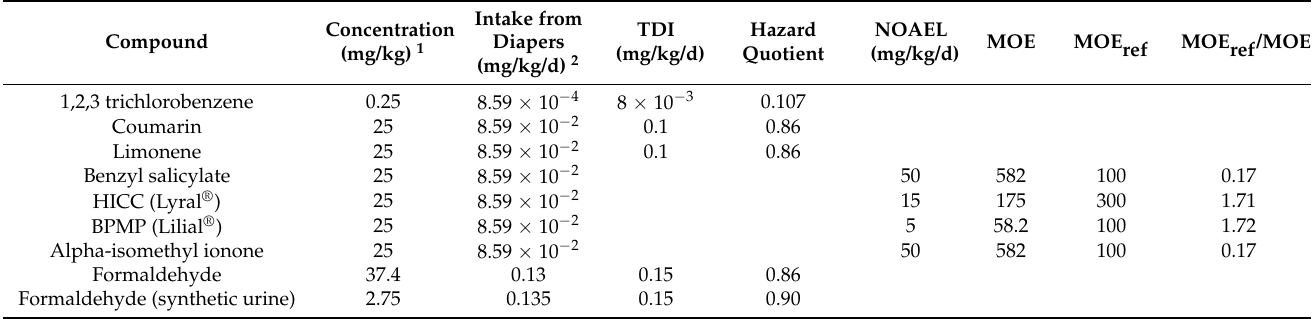
Table 8. Risk assessment conducted by ANSES for other compounds detected or quantified in diapers at potentially unsafe